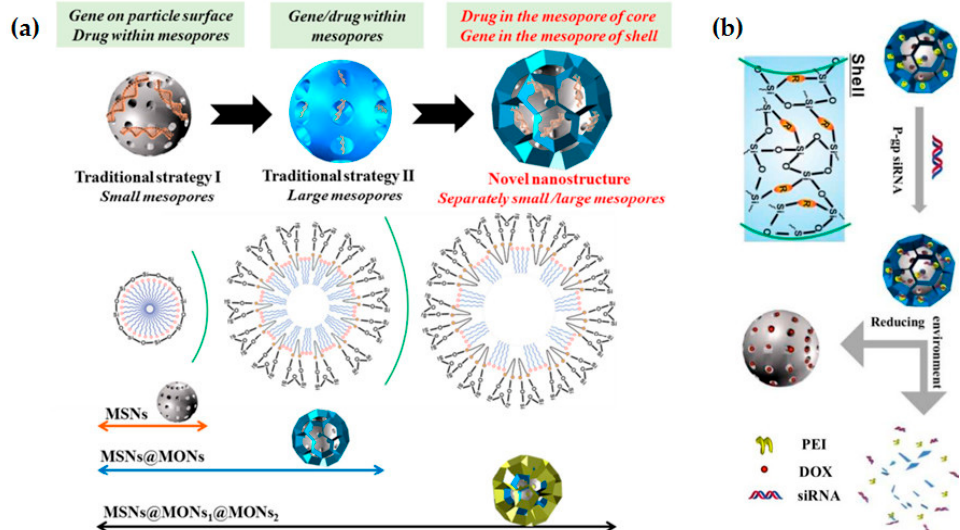
Figure 10. ( a ) Schematic illustration of the structural evolution and formation mechanism of MSNs from small to large pore-sized MSNs, and core-shell hierarchical MSNs (with small and large pores for drug and gene co-delivery); ( b ) Breaking-up of the mesoporous organosilica shell of the nanoparticles under reductive environment and consequent siRNA and DOX release. Adapted from [58], with permission from Elsevier.